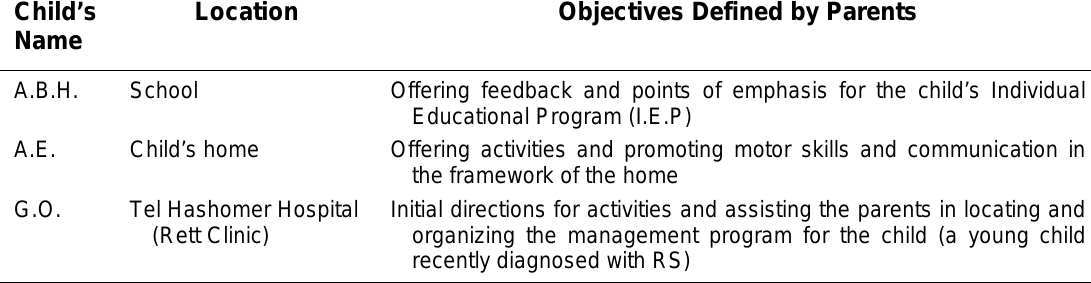
Assessment Location and Objectives as Defined by the Child’s